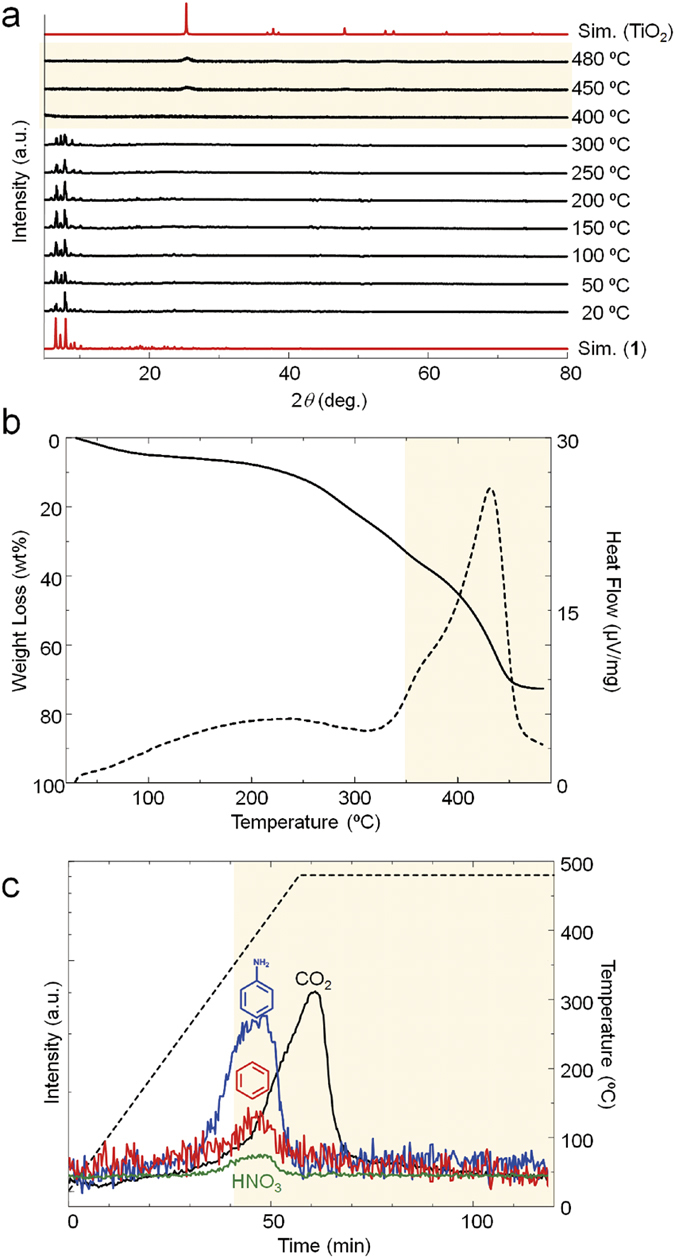
Time course experiments on calcination of the coordination cluster.(a) PXRD of 1 at variable temperature 20–480 °C. (b) TG analysis showing weight loss of 1 upon heating (black solid). DTA analysis showing exothermal peak around after 350 °C (black dots). (c) Q-MS analysis with heating of 1: aniline (m/z: 95, blue), benzene (m/z: 79, red), CO2 (m/z: 44, black) and HNO3 (m/z: 63, green) were observed. Black dot line shows temperature of the sample cell. The yellow back ground indicates the temperature region for the formation of TiO2.